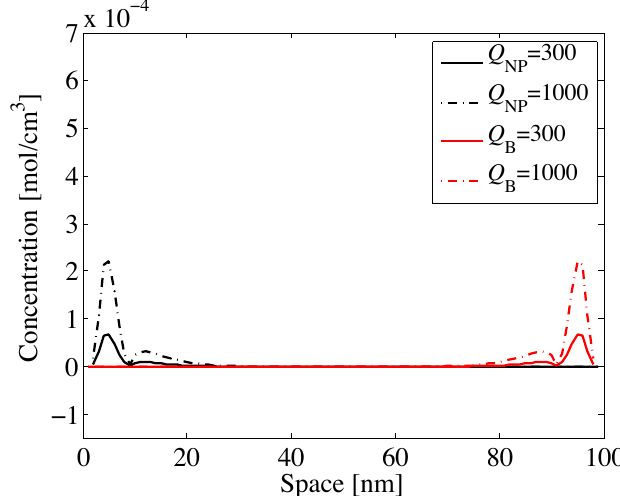
Figure 2. Variation of nanoparticle and B-cell concentrations vs . space and for different values of initial concentration Q NP/B